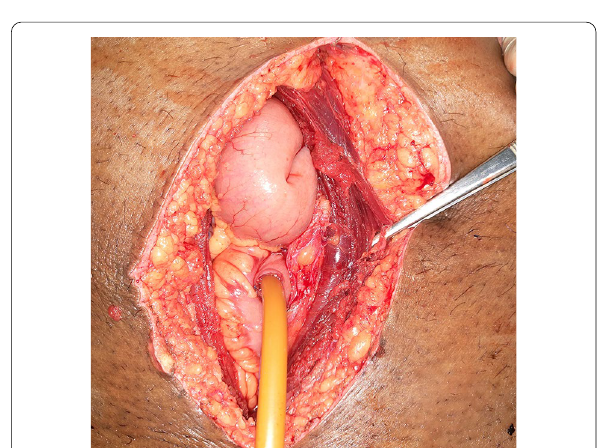
Fig. 12 Completed anastomosis with SPC in